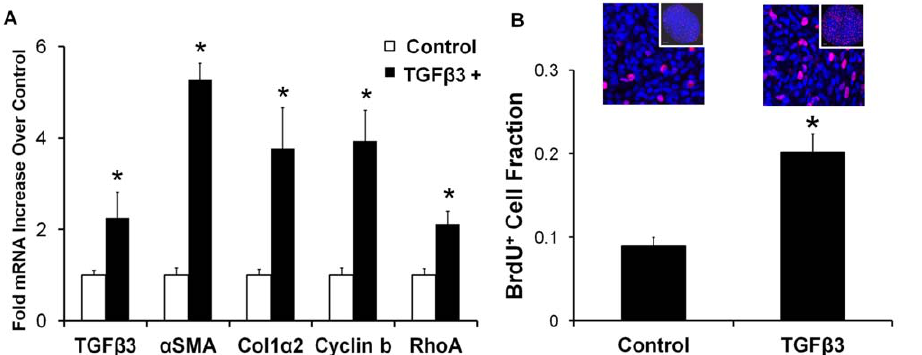
Figure 3. Remodeling behavior of TGF b 3 treated cushions is a balance of contractile differentiation, proliferation, and matrix synthesis. A ) 24 hour TGF b 3 treated cushions upregulate contractile ( a SMA, RhoA), proliferation (cyclin b), and extracellular matrix protein (col1 a 2) encoding genes. TGF b 3 administration also significantly stimulated its own production. mean 6 SEM, n=3–4 pooled samples of 8–10 cushions, *p , 0.05, t-test. B ) BrdU incorporation data (red) of TGF b 3 treated cushions normalized to DRAQ5 cell nuclei counter stain (blue). BrdU